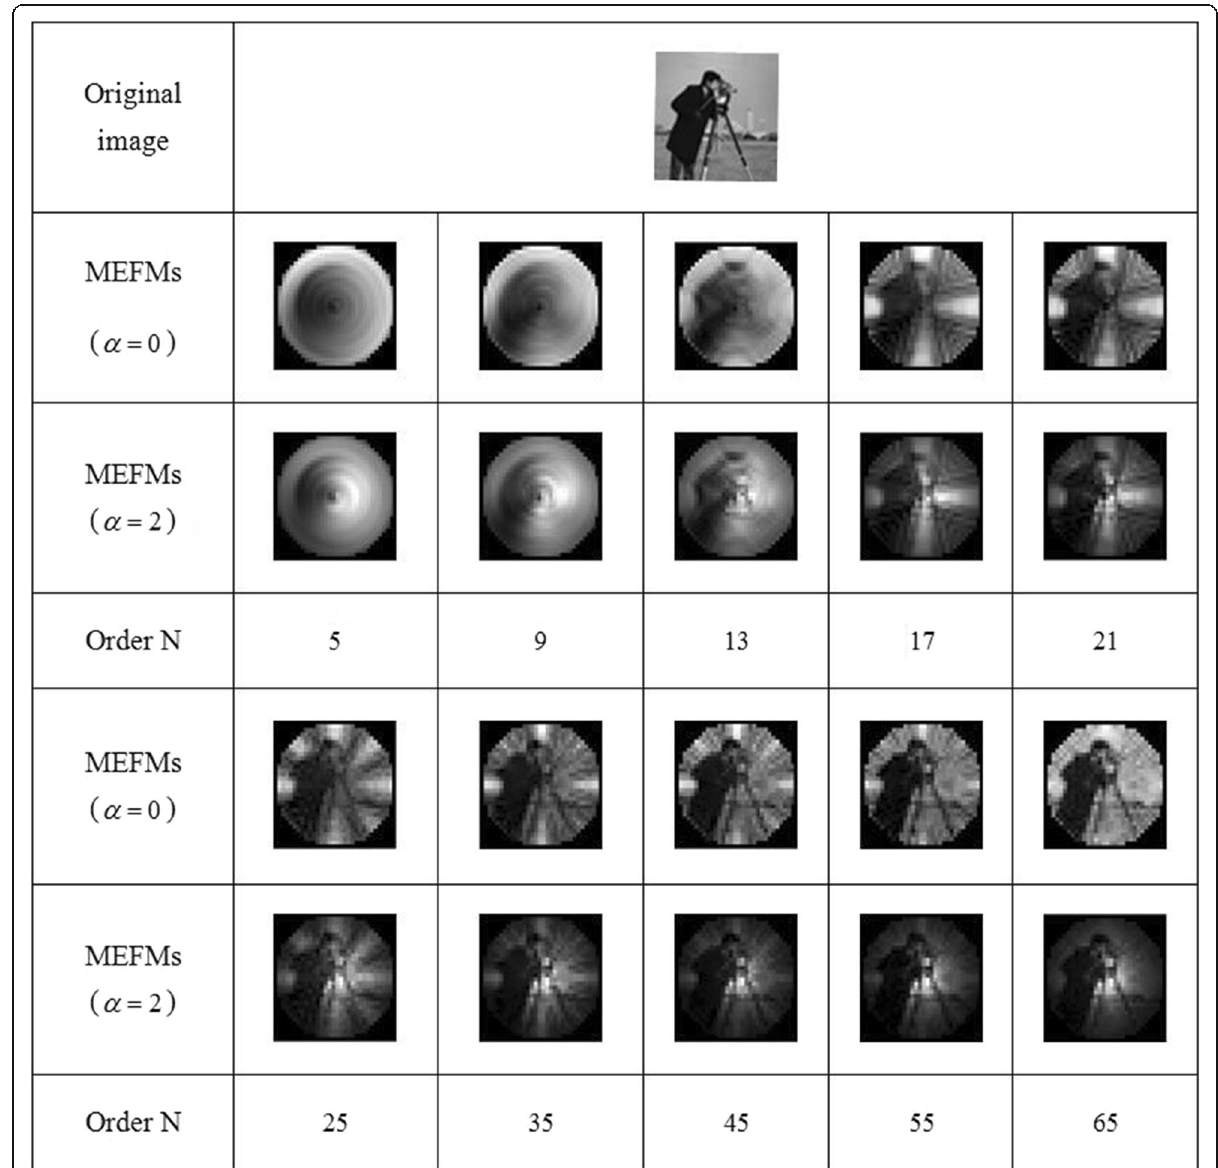
Fig. 9 Gray-level image cameraman are reconstructed in parameters ( α = 0 and α = 2) under different order